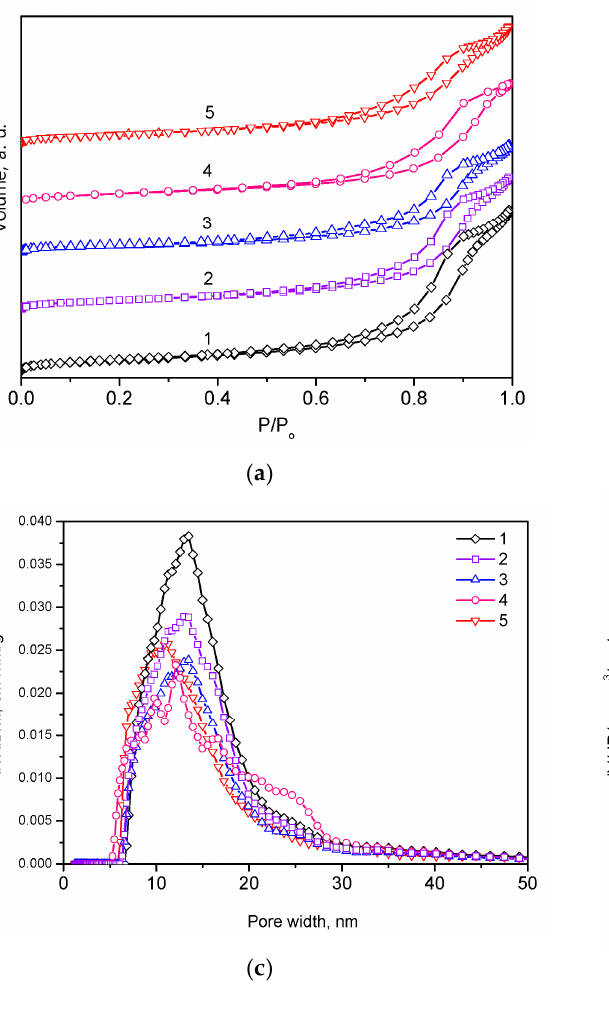
Figure 2. N 2 adsorption–desorption curves ( a , b ) and distribution of pore size ( c , d ) for Al 2 O 3 sup- port 20Ce 0.2 Ni 0.8 O 1.2 /Al 2 O 3 -SG (5) catalysts after calcination ( a , c ) and following reduction ( b , d